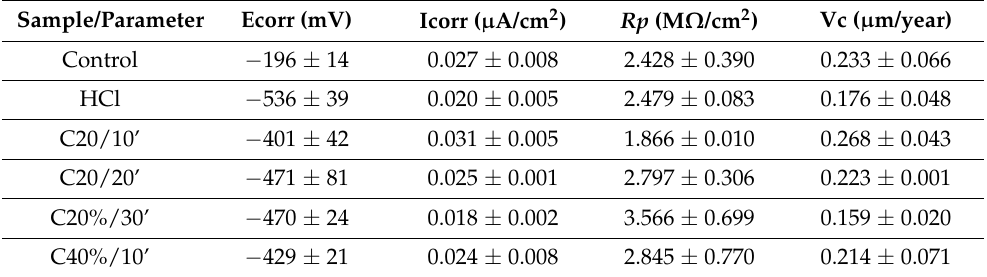
Table 5. Electrochemical parameters obtained from potentiodynamic